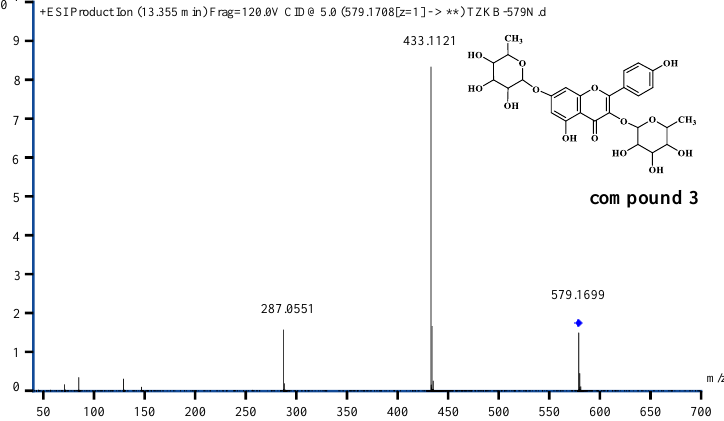
Figure 4. PIMS of kaempferol 3-O-rhamnoside 7-O-rhamnoside (compound 3 ). The blue sign was used to mark the precursor ion.